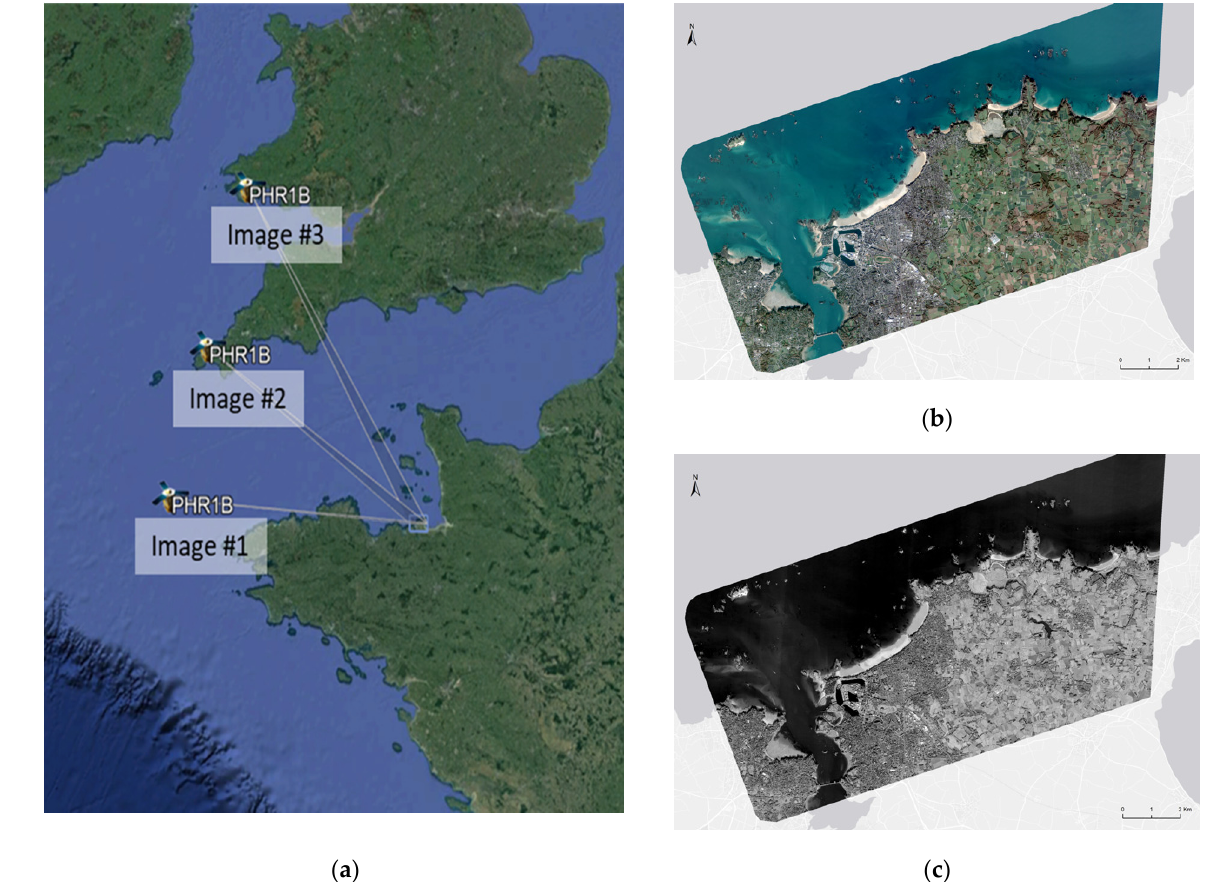
Figure 2. Viewing directions with respect to the target area of the tri–stereo Pleiades–1 images ( a ); natural–coloured nadiral imagery at 2 m pixel size ( b ), and panchromatic nadiral imagery at 0.5 m pixel size ( c ) of the study site.